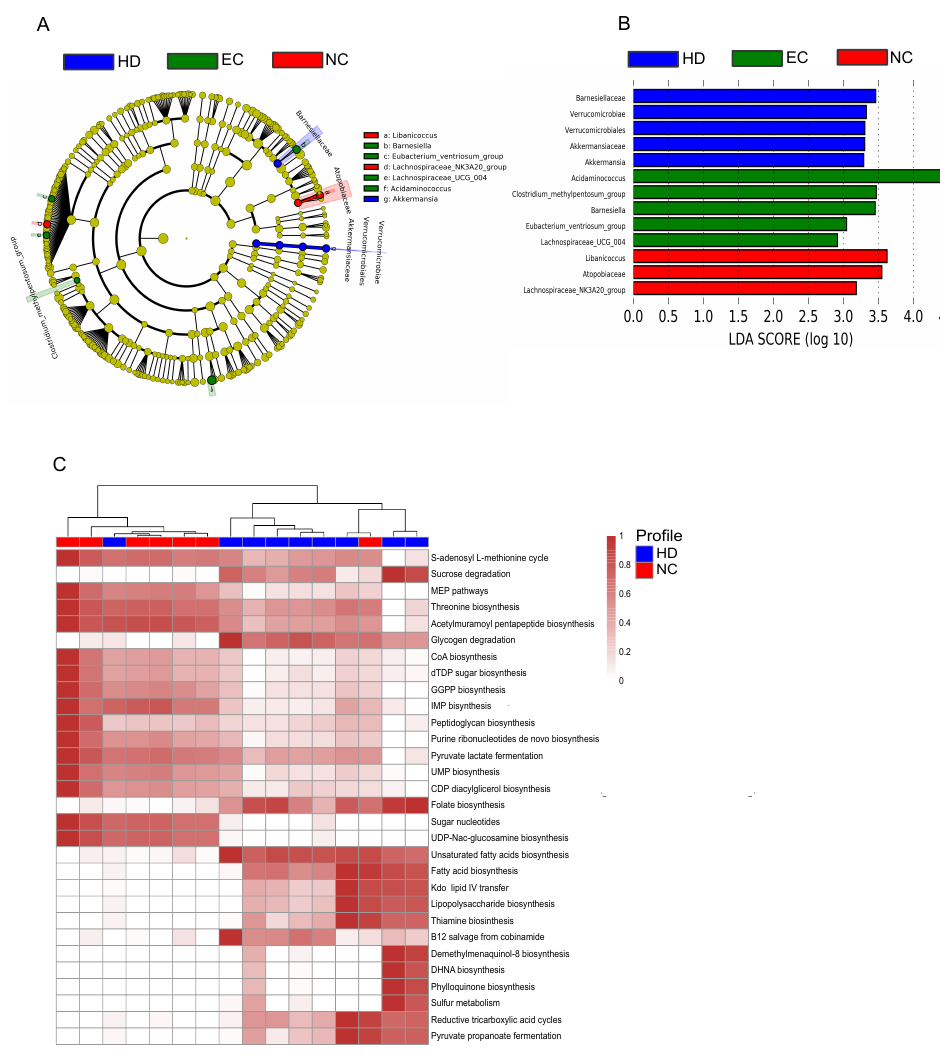
Figure 2. Taxonomic differences and inferred functional content of gut microbiota of healthy donors (HD), elite controllers (EC), and non-controllers (NC). LefSe results for the bacterial taxa that were significantly different between HD, EC, and NC groups. The cladogram showing differentially abundant taxonomic clades ( A ) and LDA scores showing significant differences between groups ( B ). Comparison of PICRUSt predicted KEGG function. The heatmap shows the relative abundance of pathways that were significantly different between HD and NC groups ( C ). Significant differences between groups were tested with Mann–Whitney test (FDR-adjusted p -value <